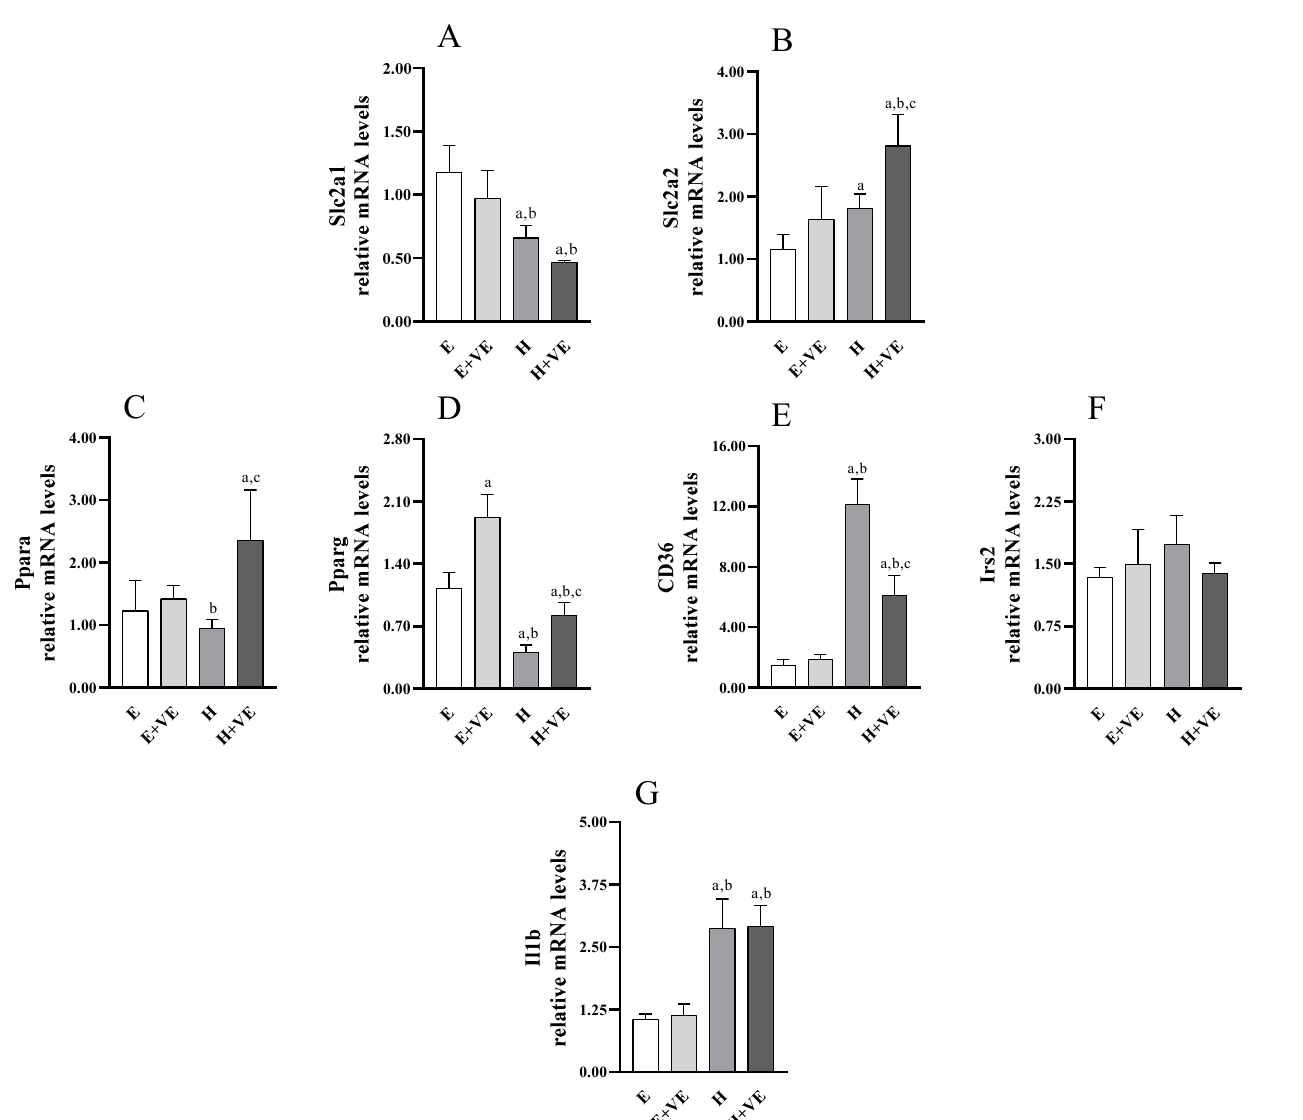
Figure 8. Relative mRNA quantification by qPCR of indicated genes (( A ) Slc2a1 ; ( B ) Slc2a2 ; ( C ) Ppara ; ( D ) Pparg ; ( E ) Cd36 ; ( F ) Irs2 ; ( G ) Il1b ). Values are means ± SEM of three determinations from different rats. Each determination is the mean of three independent measures. E, euthyroid; E + VE, euthyroid fed vitamin E supplemented diet; H, hyperthyroid; H + VE, hyperthyroid fed vitamin E supplemented diet. a significant vs. E. b significant vs. E + VE. c significant vs. H. The level of significance was chosen as p < 0.05.